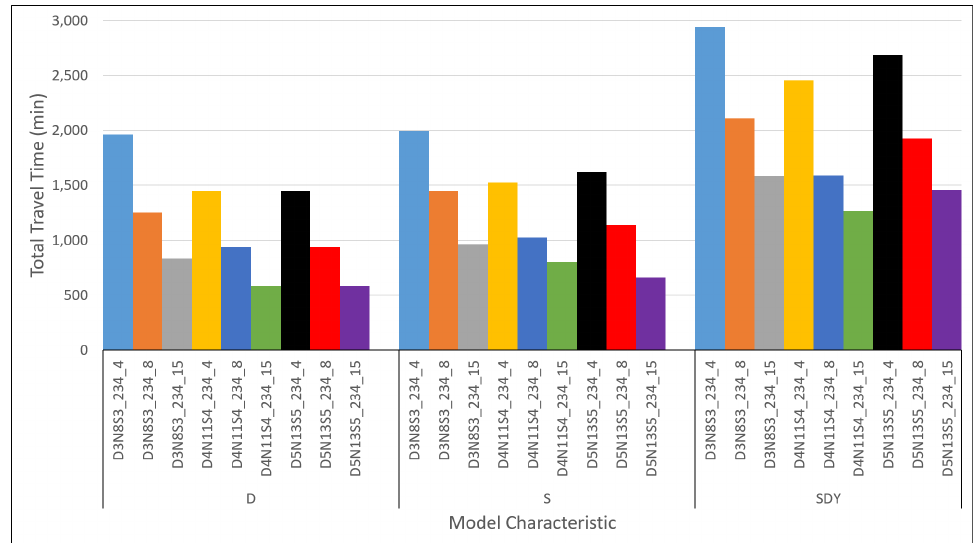
Figure A17. Total Travel Time for Maximum Road Capacity Setting ( 2,3,4 ) in Online and Offline Computation for all Instances grouped by Model Characteristic.